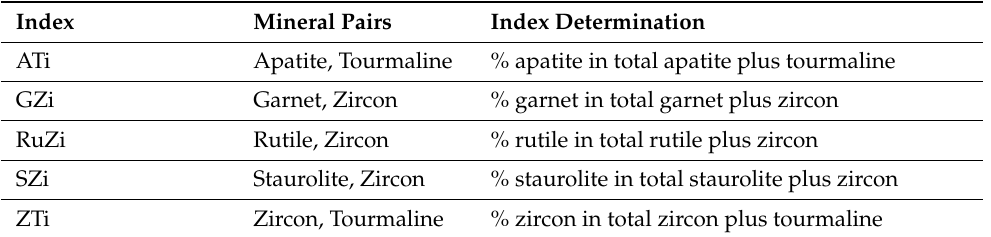
Table 1. Summary of heavy mineral indices discussed in this paper, after Morton and Hallsworth [31] and Morton et al. [53]. GZi, ATi and RuZi are provenance specific, whereas ZTi is affected by hydraulic conditions since it compares abundances of minerals with different densities. SZi is potentially controlled by diagenesis since staurolite is unstable during deep burial conditions